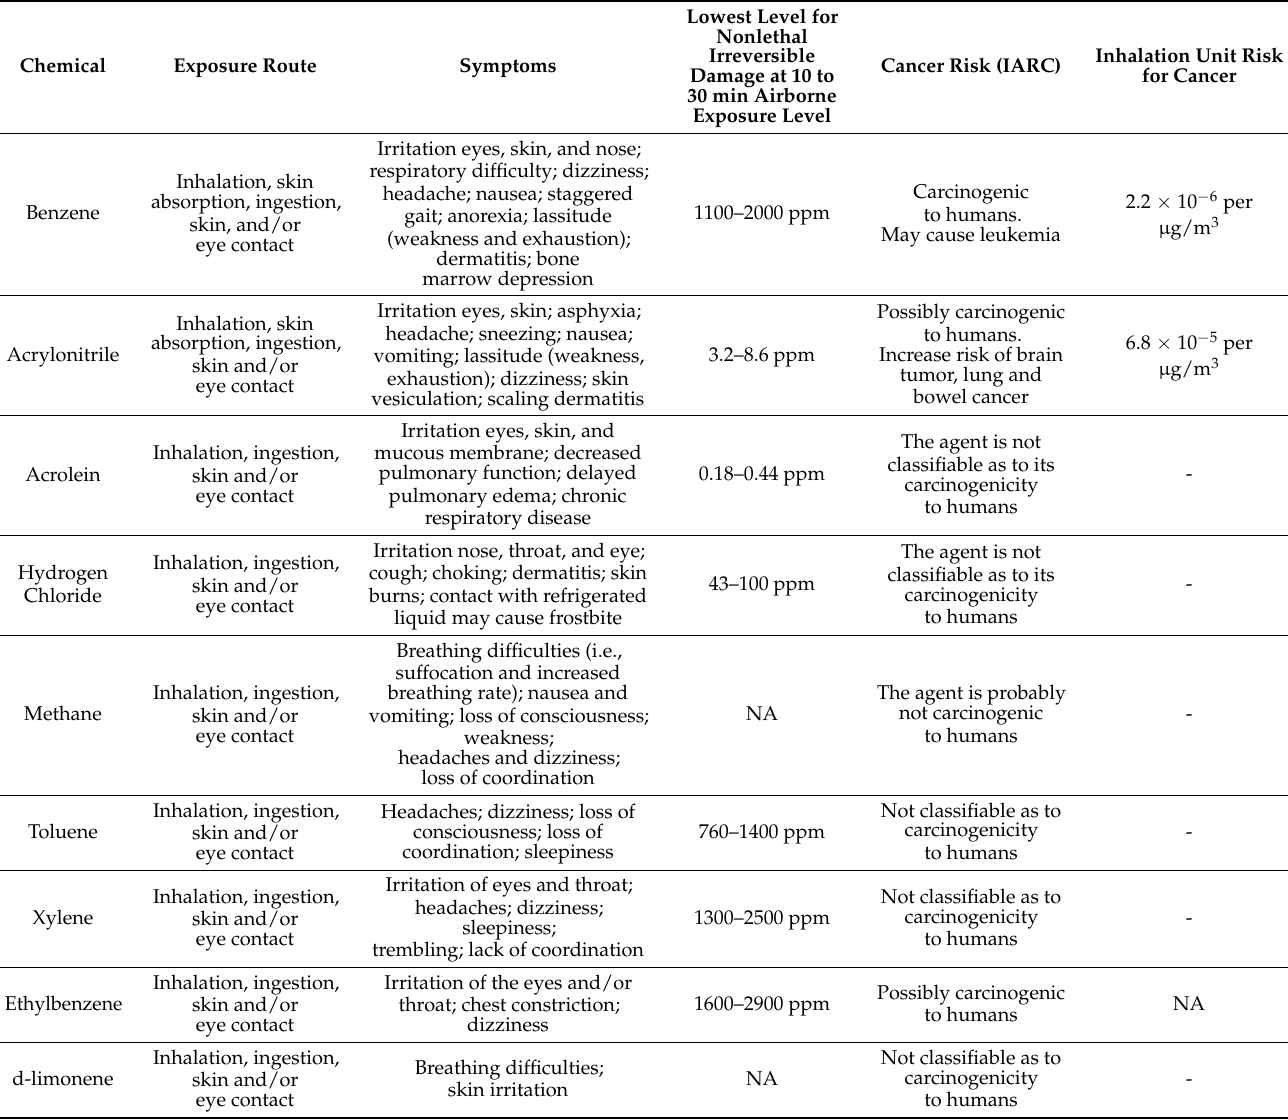
Table 1. List of chemicals found at the dumping site and the health effects